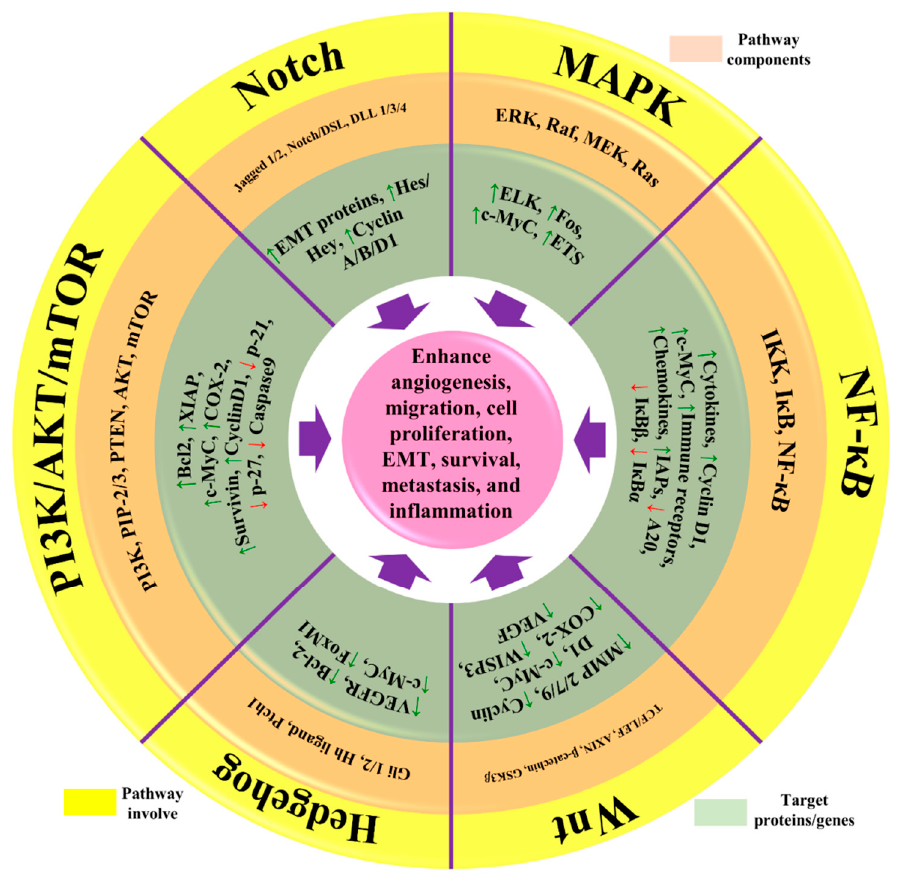
Figure 2. The representation of aberrant signaling pathways involved in BC. The green arrow rep- resents the upregulation/activation, while the red arrow represents downregulation/inhibition. This figure is reproduced from Varghese et al. [44] (Creative Commons Attribution License (CC BY 4.0)). During BC development, epithelial cells change from neoplastic cells into cancerous